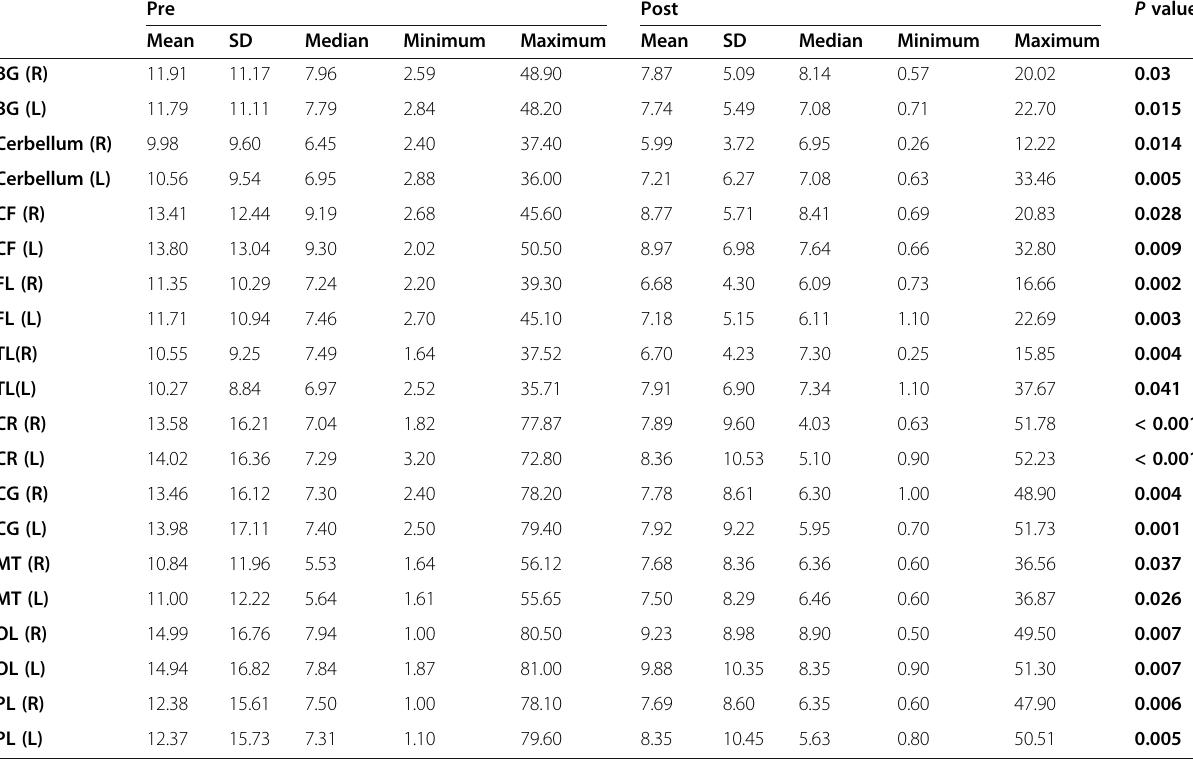
Table 2 The mean, standard deviation (SD), median, minimum, and maximum of the different regions before (Pre) and after (Post) chemotherapy Pre Post P